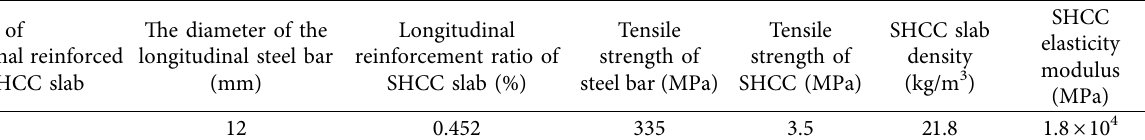
Table 3: Experimental model parameters.